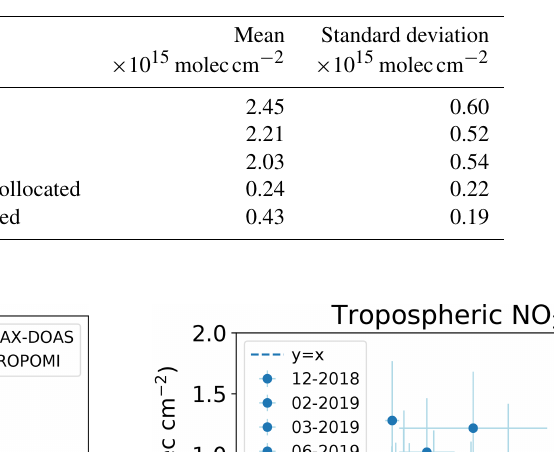
Table 3. Statistical results of the comparison of TROPOMI and MAX-DOAS stratospheric NO 2 vertical column densities. MAX-DOAS collocated is the MAX-DOAS stratospheric NO 2 VCD collocated with TROPOMI measurement. TM5 interpolated is the MAX-DOAS stratospheric NO 2 VCD interpolated using the TM5 stratospheric NO 2 diurnal cycle.